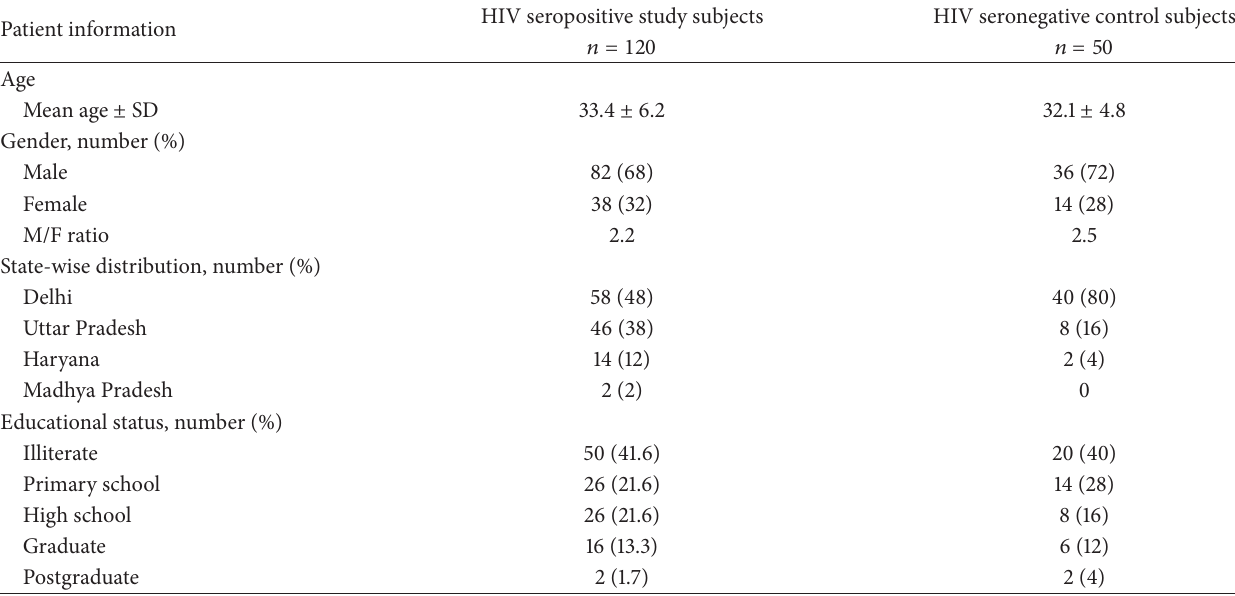
Table 1: Sociodemographic profile of study subjects.